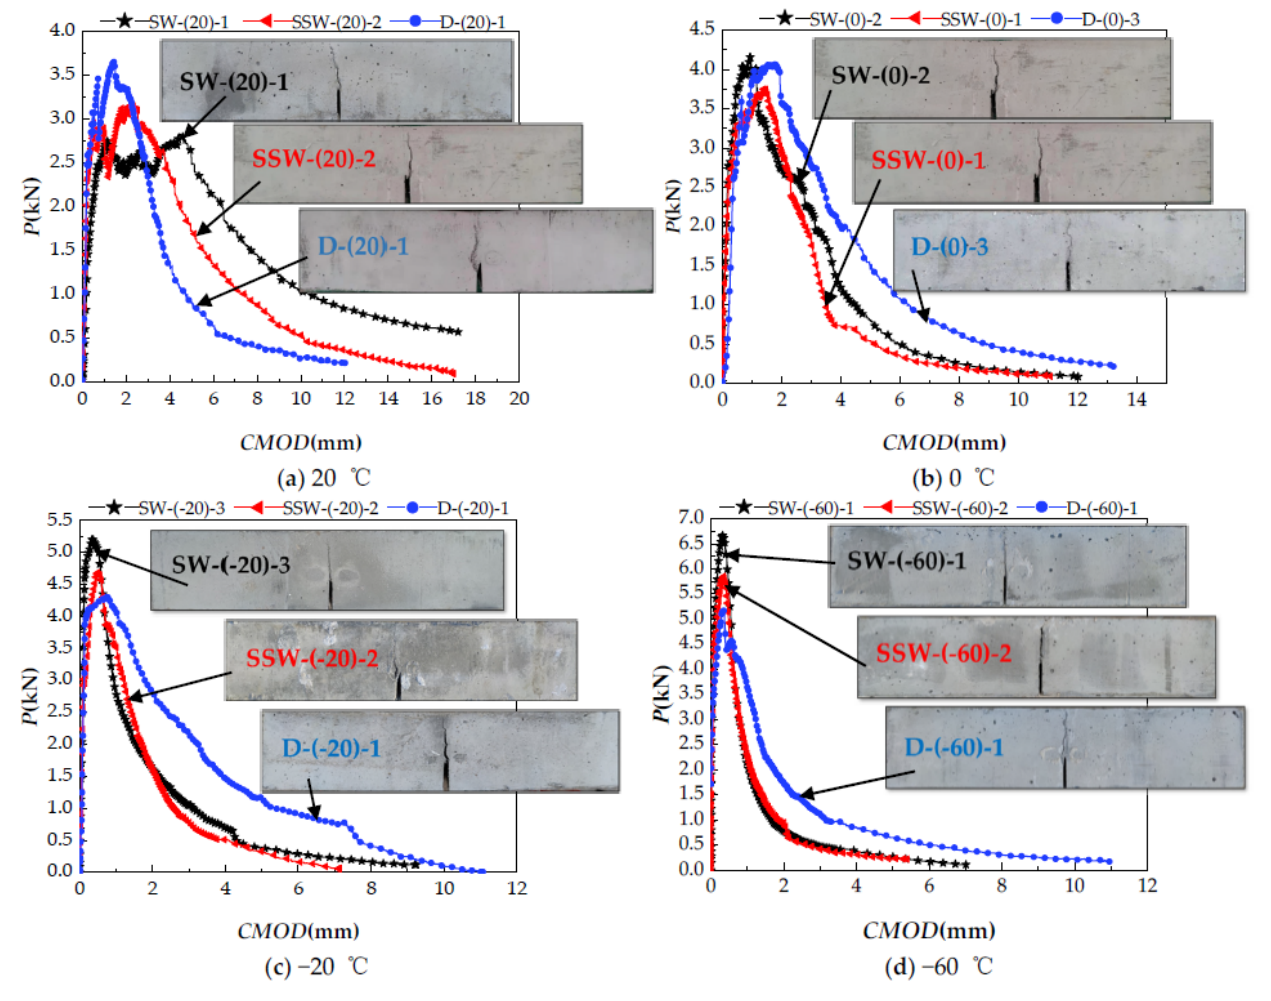
Figure 10. P-CMOD curve and fracture morphology of SW, SSW, and Dat; ( a ) 20 °C; ( b ) 0 °C; ( c ) − 20 °C; ( d ) − 60 °C.